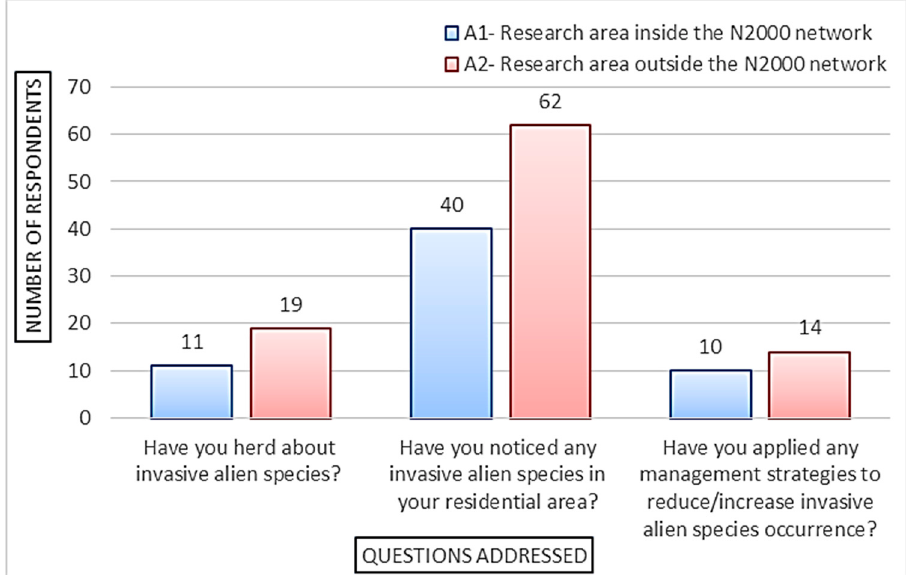
Figure 6. Knowledge regarding the invasive alien species. The number of respondents comprises of those individuals which answered “Yes” to the question